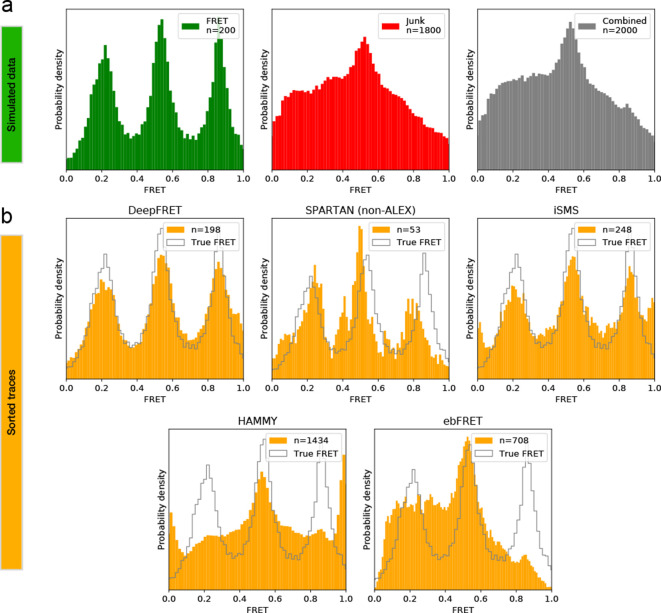
Comparison of DeepFRET, SPARTAN, iSMS, HAMMY, and ebFRET performance on simulated, ground truth data.(a) 200 simulated, ground truth smFRET traces (left) were merged with 1800 simulated, non-smFRET traces (middle) to yield a combined distribution of 2000 traces (right). (b) Performance of DeepFRET, SPARTAN, iSMS, HAMMY, and ebFRET on the simulated data employing various sorting criteria. In SPARTAN, six commonly used thresholds were employed on parameters including donor/acceptor correlation, SNR, intensity, FRET lifetime, exclusion of photoblinking, and step-wise drops in fluorescence intensity. In iSMS, aggregates were removed by intensity thresholds with subsequent sorting based on stoichiometries of ~0.4–0.6 and removal of FRET outliers. In HAMMY, sorting was based on intensity thresholds, while in ebFRET, sorting was based on the removal of FRET outliers (0 < E < 1). Data is displayed without applying correction factors. Note that, expert users can navigate through all thresholds and define their own to further, and even more accurately, optimize data selection of both SPARTAN and iSMS, while HAMMY and ebFRET may require additional manual selection or sorting via other software packages. DeepFRET only required a single quality threshold of 0.8.